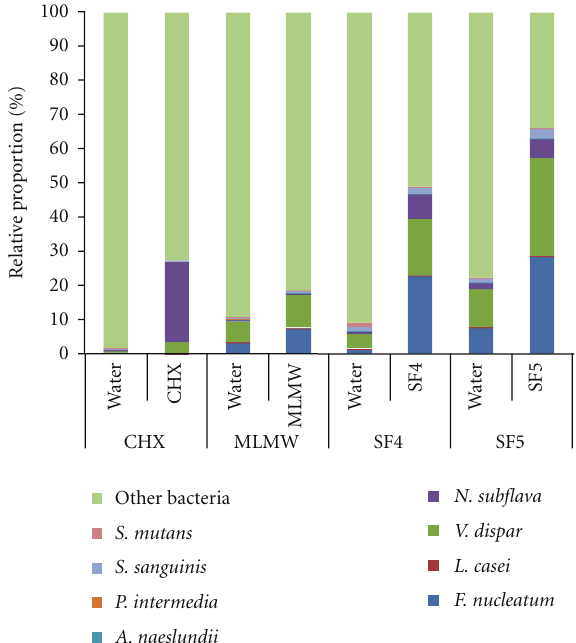
Figure 5: Relative proportions of microorganisms in microcosm samples. The other bacteria were calculated as the di ff erence between the universal probe counts and the sum of the 8 targeted probe counts. The data are average from 6 samples obtained in 2 CDFF runs per treatment. CHX—chlorhexidine digluconate; MLMW—mushroom low molecular weight fraction; SF4—subfraction nr 4 of MLMW fraction; SF5—subfraction nr 5 of MLMW